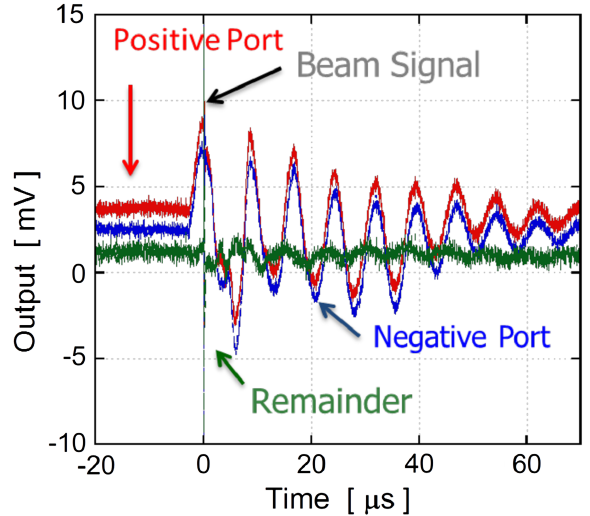
FIG. 14. Function in order to reduce any common-mode noise. The upper signal (red line) is from the positive port of the DCT in the horizontal. The second (blue line) is from the negative port. The third (green line) is the subtracting signal between the positive and negative